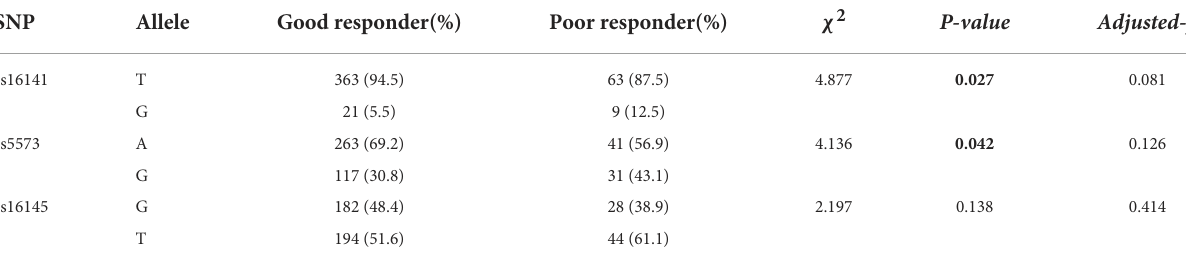
TABLE 4 Comparison of SNPs allele distribution in two